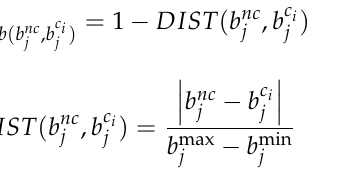
Numerical Attributes.